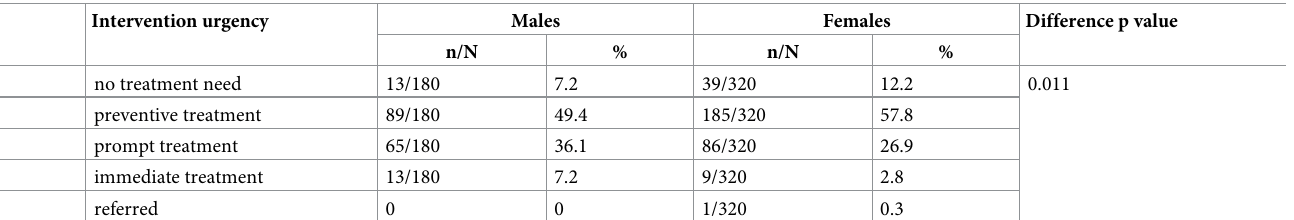
Table 4. Treatment needs.